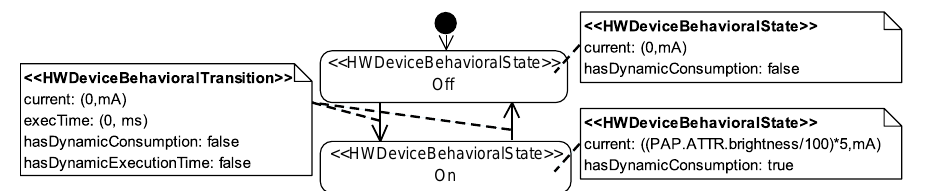
Figure 12. Annotated state diagram of the dimmable LED example. Unused tagged values have been omitted to improve legibility (UML 2.5 state machine diagram